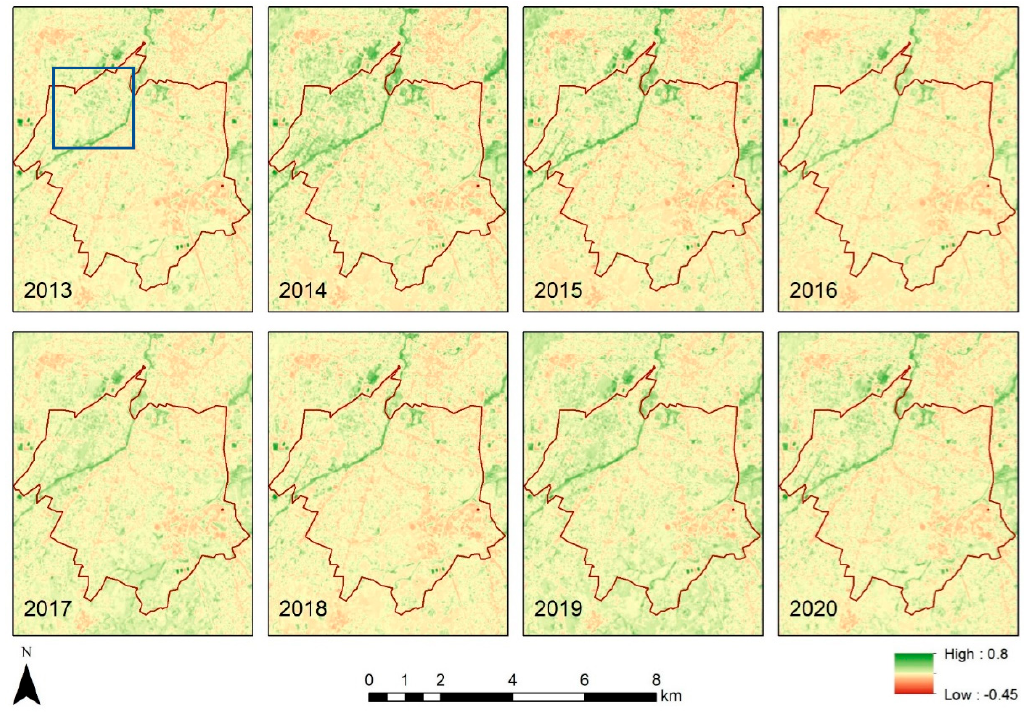
Figure 6. NDVI maps for the case study (a) (Strovolos) per year.